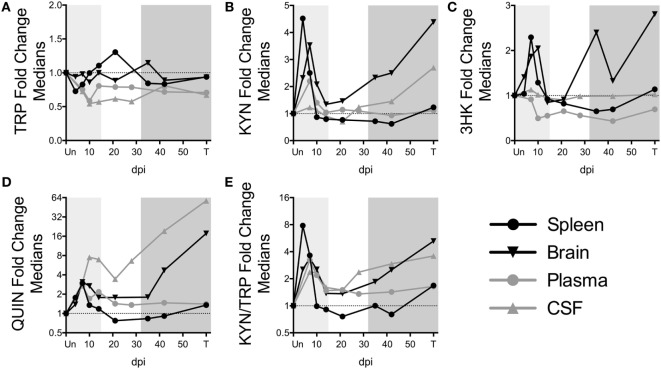
Comparison of fold changes in kynurenine pathway metabolites in spleen, brain (striatum), plasma, and CSF from SIV-infected pigtailed macaques. The median fold changes for tryptophan (TRP) (A), kynurenine (KYN) (B), 3HK (C), QUIN (D), and KYN/TRP ratios (E) are overlaid for each respective tissue. The horizontal dotted line represents the median of uninfected animals. Light gray shading represents the acute phase of infection (0–14 dpi), and dark gray shading represents the chronic phase of infection (≥35 dpi) in our model. Striatal brain and CSF metabolite data have been modified from a previously published version (32).